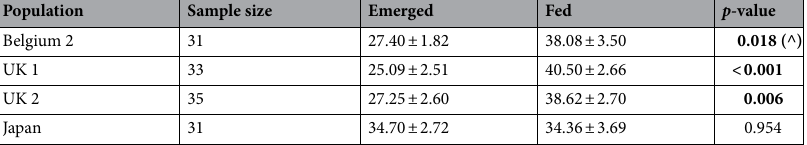
Table 3. Plasticity irrespective of host species identity. Mean absolute fat amount ± 1se (in μg) was quantified in adult wasps from field-caught and laboratory-based L. heterotoma populations raised on fat-poor D. melanogaster at two time points during adult life (Emerged: just after emergence; Fed: having fed for 7 days after emergence). P -values (corrected for multiple testing) reveal that fat synthesis took place in three of the four wasp populations (in bold), meaning that lipogenesis is also plastic when measured using the same host strain. T-tests were performed when data was normally distributed and variances equal with (^) or without log transformation. Population Belgium 1 was not available for testing on lean D.